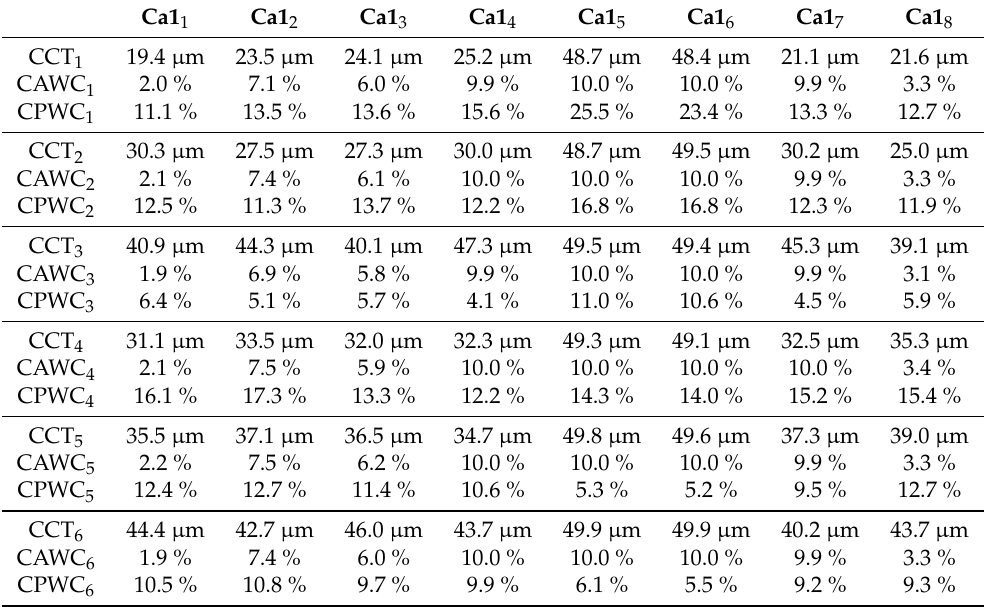
Table 3. RMSD of estimated CCT, CAWC, and CPWC for six noisy cornea calibrated with various noisy perturbed PEC sphere at frequency band of WR 3.4. The SNR 60 dB is